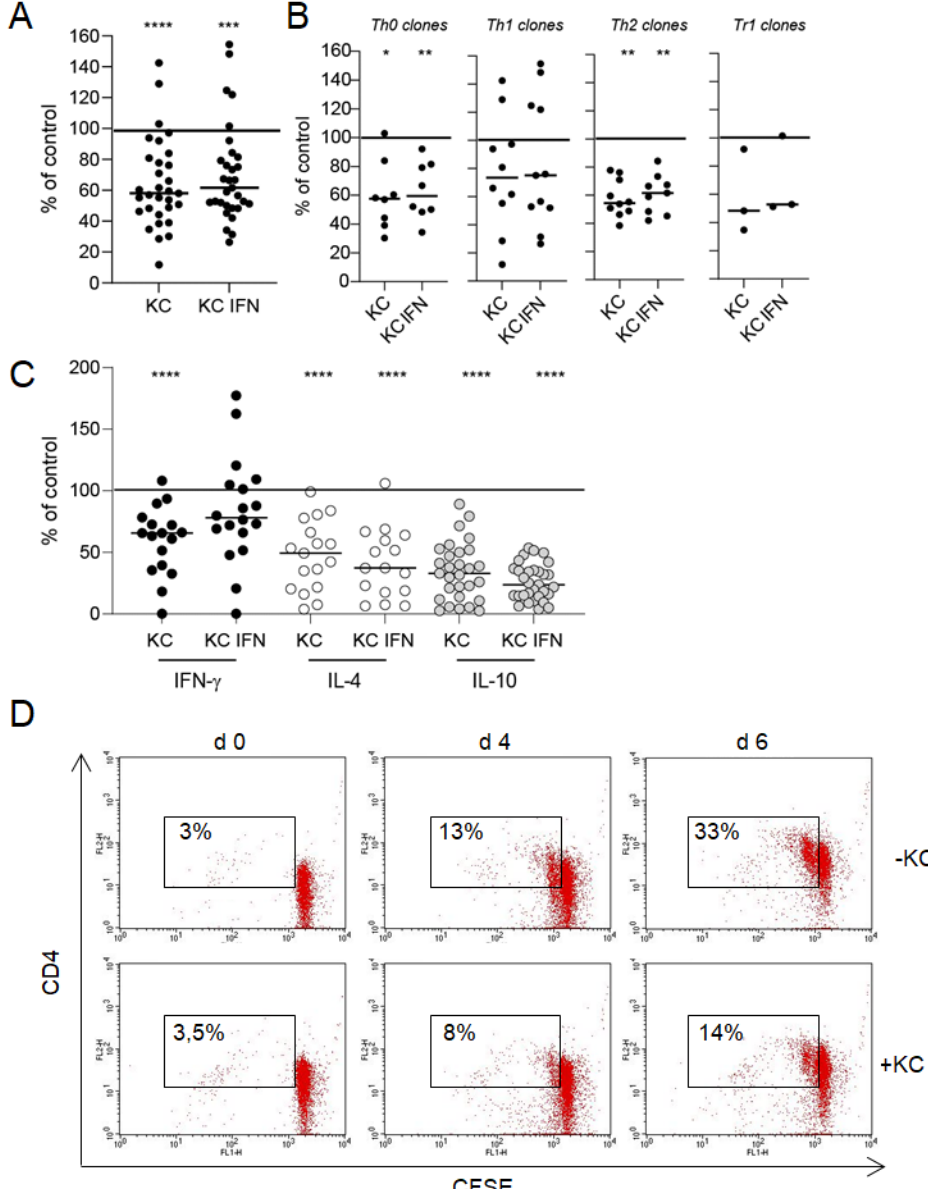
Figure 2. Interaction between keratinocytes and T cells results in an inhibition of T cell effector functions. Keratinocytes (KC) or IFN- γ prestimulated keratinocytes (KC IFN), autologous nickel-specific T cell clones and DCs were incubated in a ratio of 10:100:1 in the presence of nickel sulfate. After 48 h, nickel-specific T cell proliferation was measured by 3H-thymidine incorporation ( A , B ), and the production of cytokines was detected in a cell-free co-culture supernatants by ELISA ( C ). Each data point represents one T cell clone with an average of at least three experiments (T cell clones pooled, panel ( A ); T cell clone subsets, panel ( B )). The line displays the median of all clones investigated. Shown is the percentage change of T cell proliferation and cytokine production compared to the control culture without keratinocytes (normalized to 100%). The inhibitory effect of keratinocytes on T cell proliferation could also be observed in a flow cytometric approach with CFSE-labeled T cell clones ( D ). The number indicates the CD4+, proliferating T cells. (( A – C ) clones = 32, n = 105, ( D ) one representative clone in co-culture with IFN- γ prestimulated keratinocytes; *: p < 0.05; **: p < 0.01; ***: p < 0.001; ****: p < 0.0001).